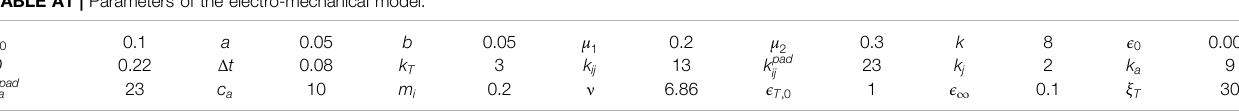
TABLE A1 | Parameters of the electro-mechanical